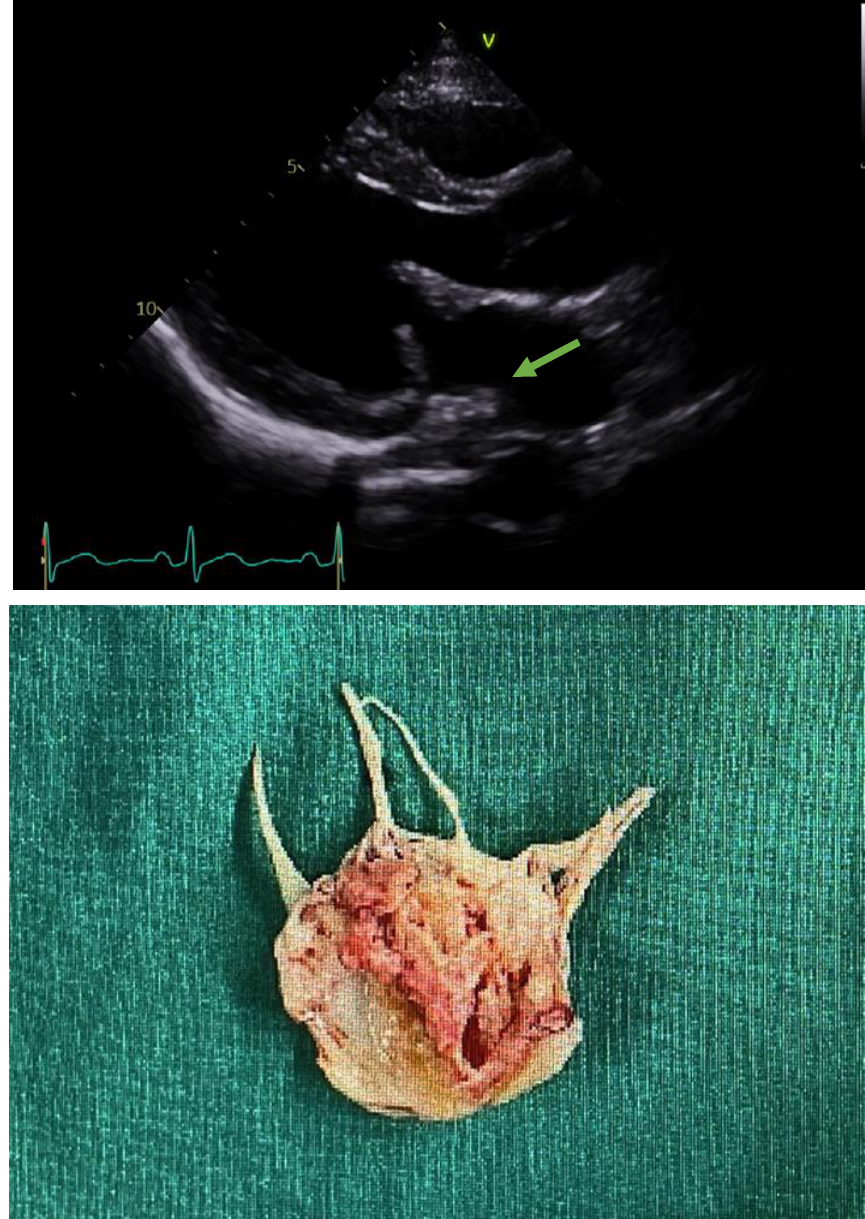
Figure 2. Infective endocarditis vegetation. The first image shows the echocardiography after hospitalization, while the second image is post-cardiothoracic surgery.